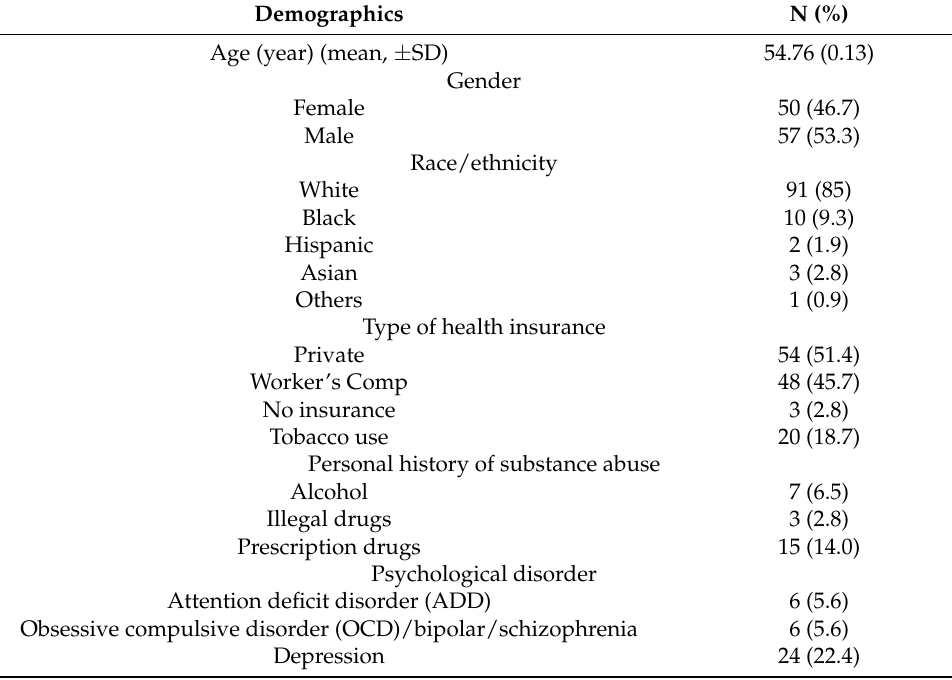
Table 1. Patient characteristics (N =